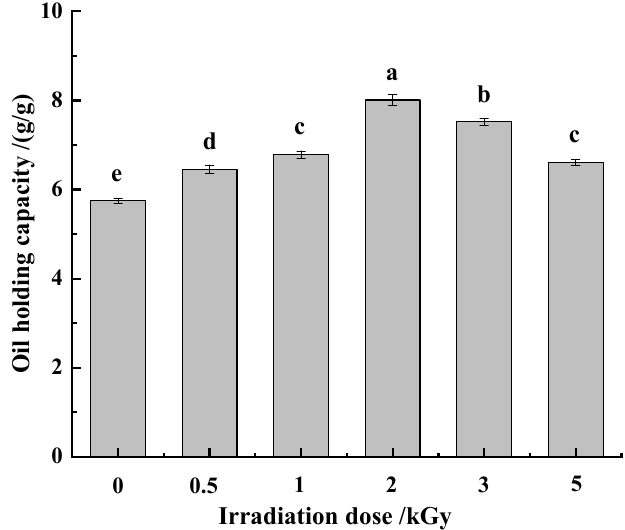
Figure 4. Effect of γ-irradiation on oil-holding capacity of pea fiber. Note: Different lowercase letters indicate significant differences in oil-holding capacity ( p < 0.05).